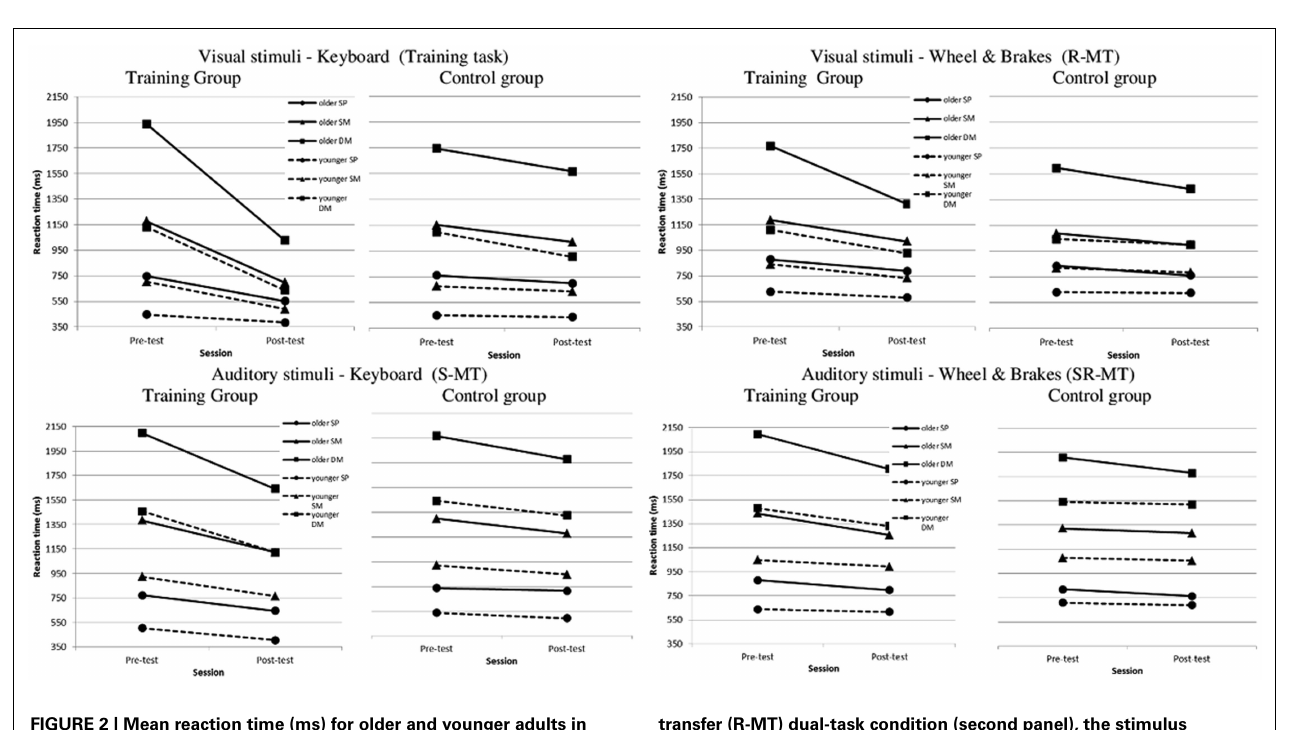
FIGURE 2 | Mean reaction time (ms) for older and younger adults in the three trial types [single pure ( SP), single mixed ( SM), and dual mixed ( DM)], as a function of pre- and post-test sessions, for the trained dual-task condition (first panel), the response modality